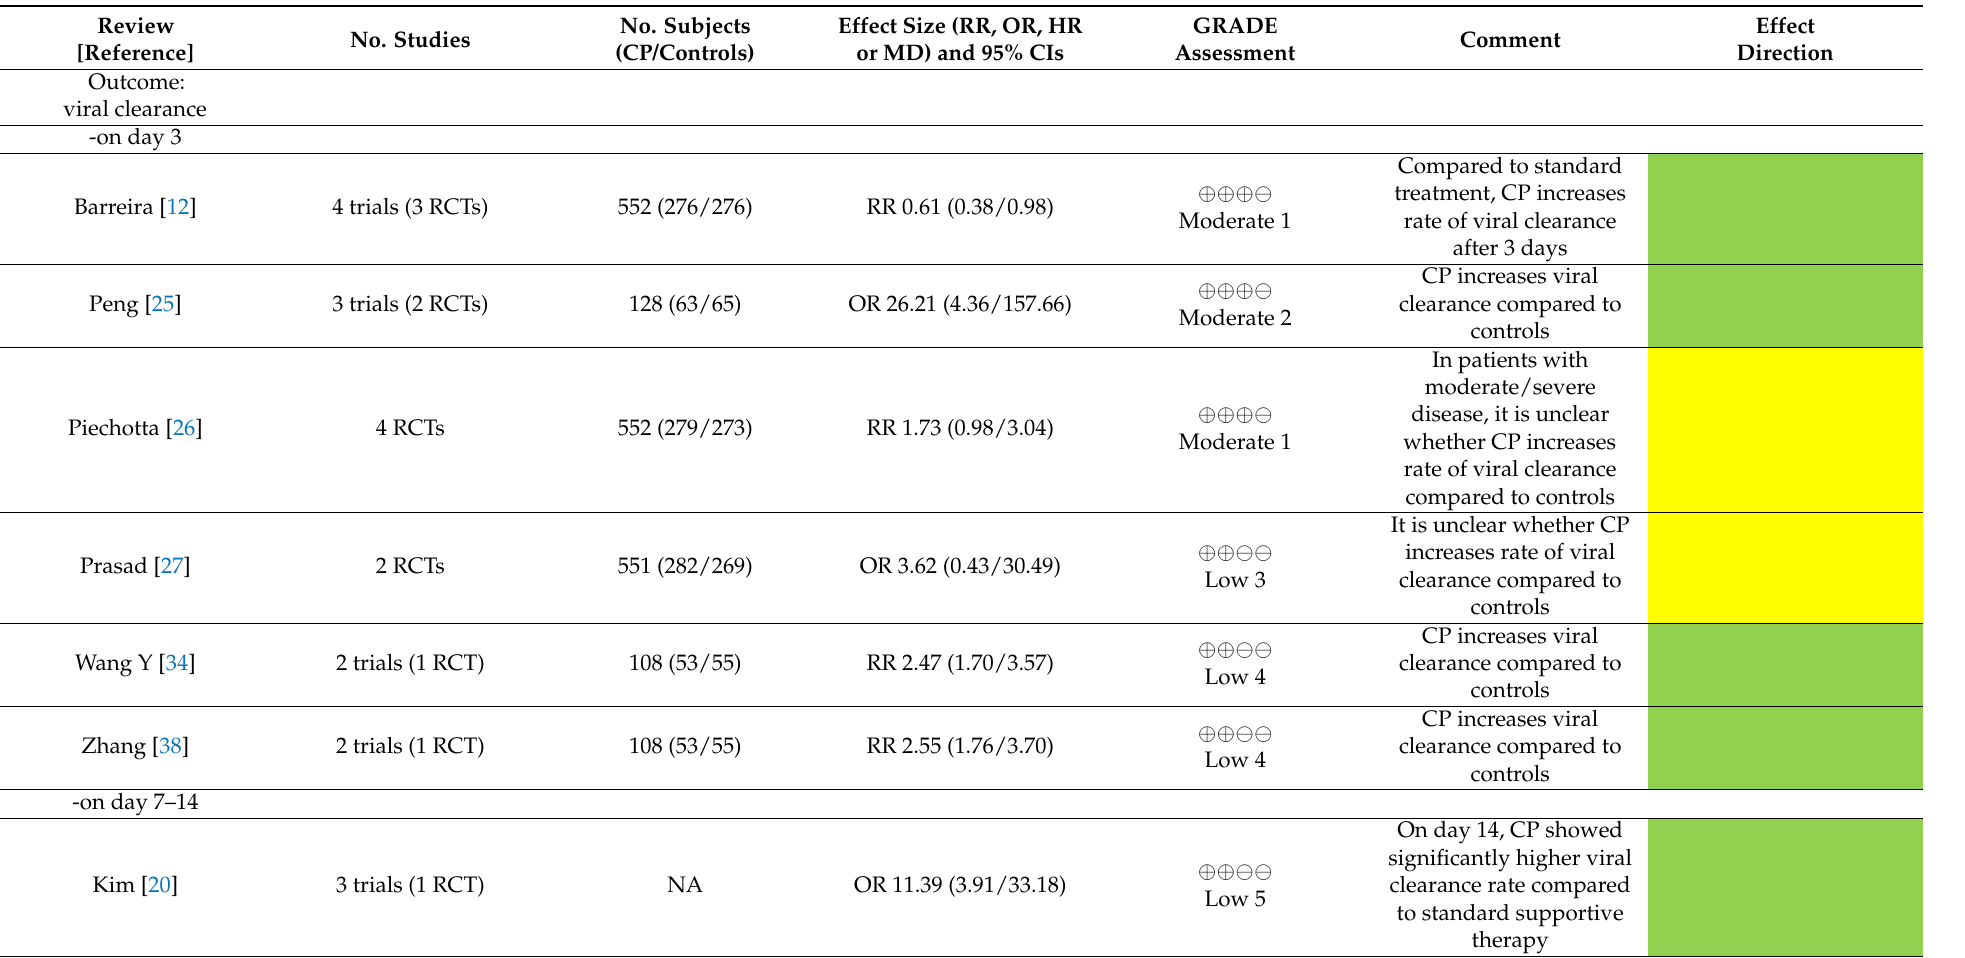
Table 4. Effects of convalescent plasma on viral clearance, clinical improvement and length of hospital